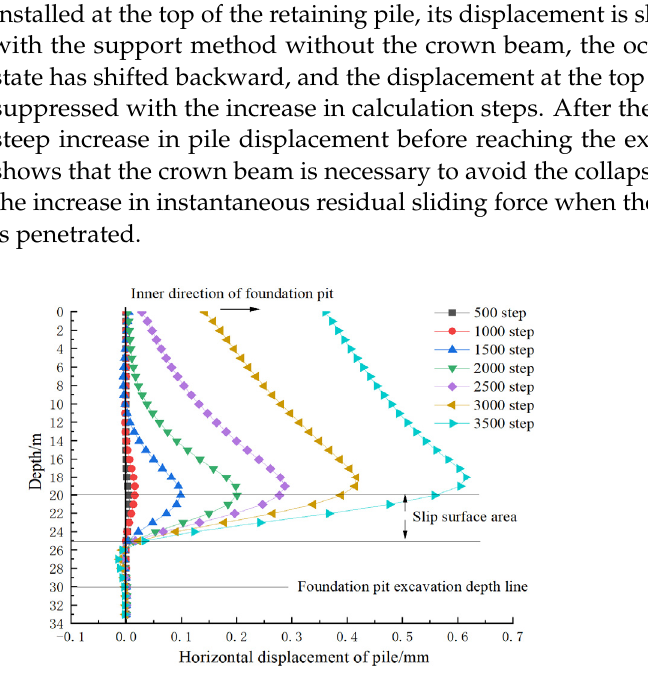
Figure 7. Displacement curve of pile body with 2.0 times pile spacing (three piles).